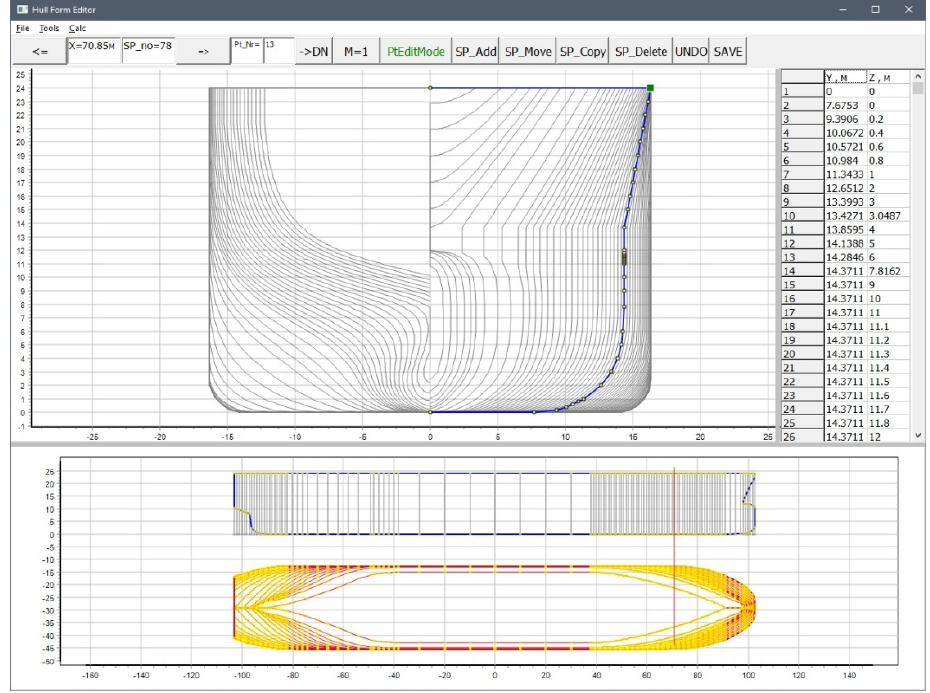
Figure 14. Visual representation of the hull geometry in a special editor.